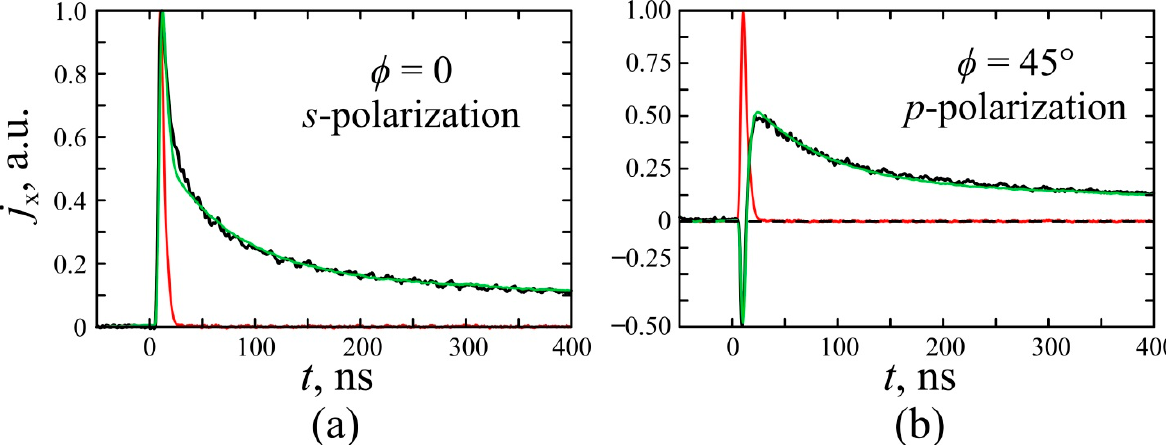
Figure 4. Oscillograms of longitudinal photocurrent pulses produced by a laser beam at different half-wave plate orien- tations: ( a ) ϕ = 0 and ( b ) ϕ = 45°. The red lines denote the exciting laser pulse while the black lines show the measured photocurrent pulse, and the green lines are the fitting by Equation (23).